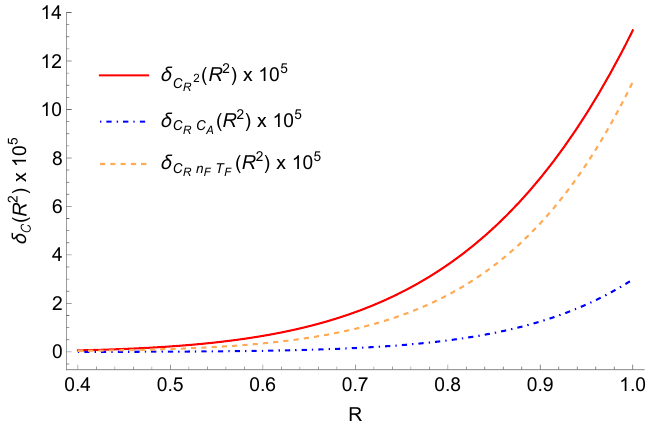
Figure 2 . The quantity δ C ( R 2 ) defined in eq. (4.4) for the three colour structures contributing to the two-loop soft function. The three curves are multiplied by a factor of 10 5